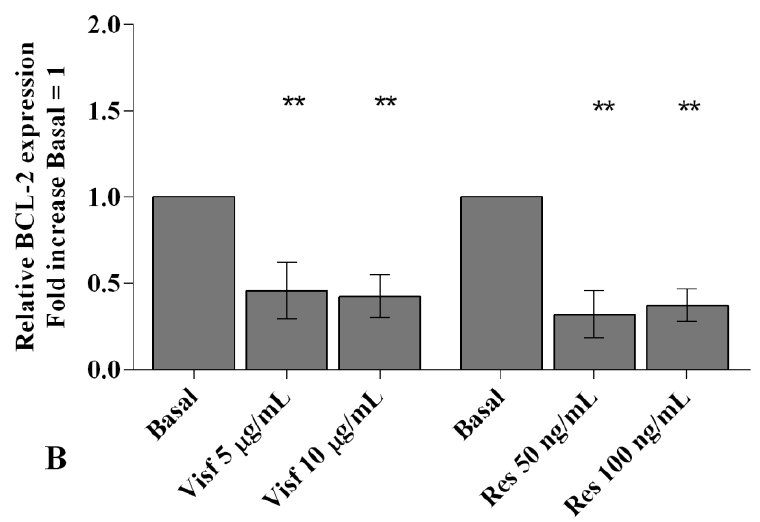
Figure 2. ( A ) Apoptosis detection performed by the analysis at flow cytometry and measured with Annexin Alexa fluor 488 assay. Data were expressed as the percentage of positive cells for Annexin-V and propidium iodide (PI) staining. ( B ) Expression levels of gene B-cell lymphoma ( BCL ) 2 by real-time PCR. Human osteoarthritic (OA) synovial fibroblasts were evaluated at basal condition and after incubation with visfatin (5 and 10 μg/mL) and resistin (50 and 100 ng/mL) for 24 h. The apoptosis ratio and the gene expression were referenced to the ratio of the value of interest and the value of basal condition (basal, cells without treatment), reported equal to 1. Data were expressed as mean ± SD of triplicate values. ** p < 0.01, *** p < 0.001 versus basal condition. Visf = visfatin, Res = resistin.